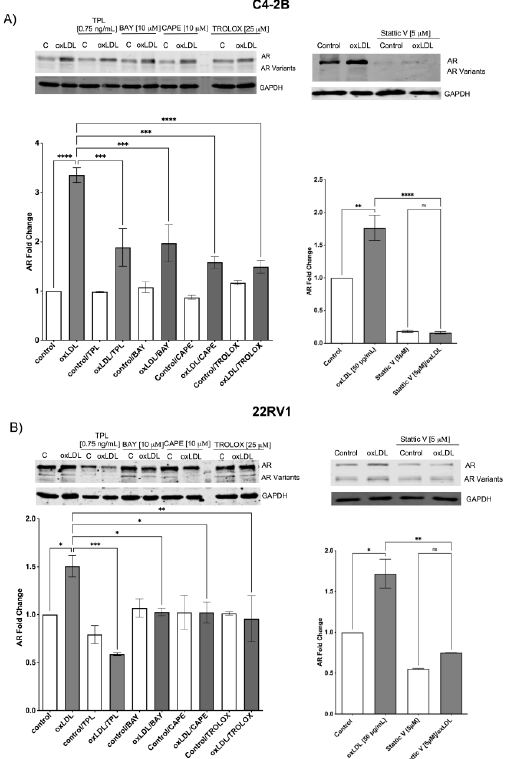
Figure 5. Inhibition of ROS generation, NF- κ B, and STAT3 prevent oxLDL-induced AR expression. ( A ) C4-2B and ( B ) 22Rv1 cells were incubated with or without Trolox, triptolide (TLP), bay 11-7082 (BAY), caffeic acid phenethyl ester (CAPE), or Stattic (STAT3 inhibitor), then were treated with 50 µ g/mL oxLDLs for 24 h and AR expression was evaluated by Western blot. The data represent the means ± S.D. of three independent experiments analyzed by one-way analysis of variance and Dunnett’s post-test (**** p ≤ 0.0001, *** p ≤ 0.001, ** p ≤ 0.01, * p ≤ 0.05, ns: non-significant statistical